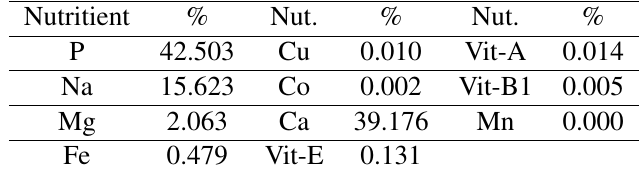
Table 3 Nutritional components for each 0.8g of One-day chicken (40g) [11]